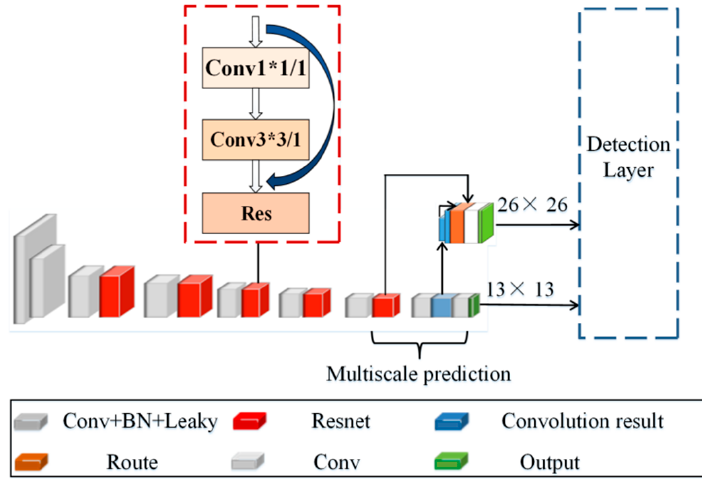
Figure 3. Structure of the improved network model.